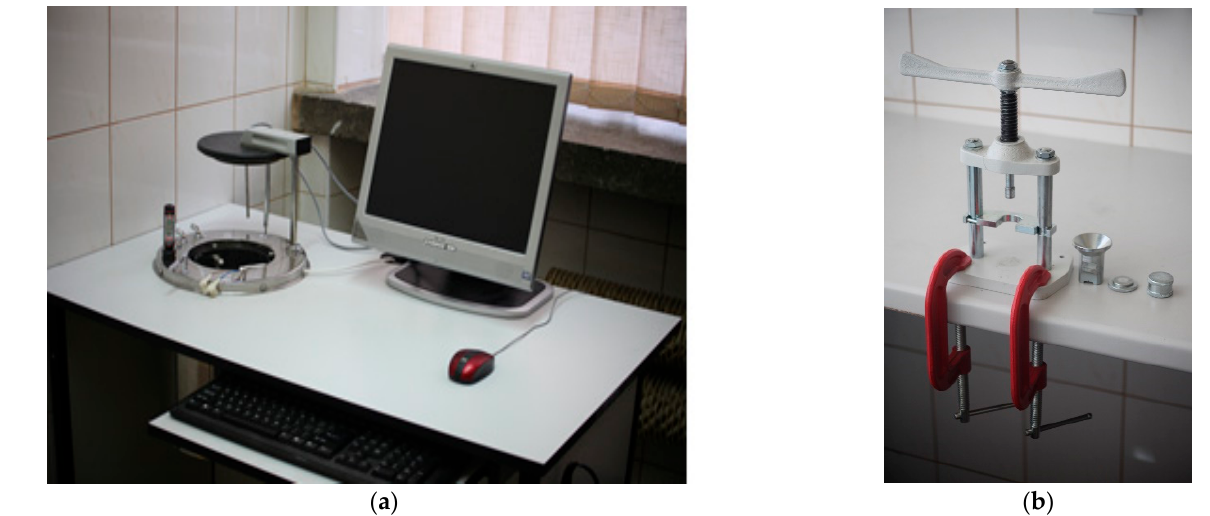
Figure 8. Elements of the stand for determining the heat of combustion: ( a ) calorimeter, ( b ) manual press.